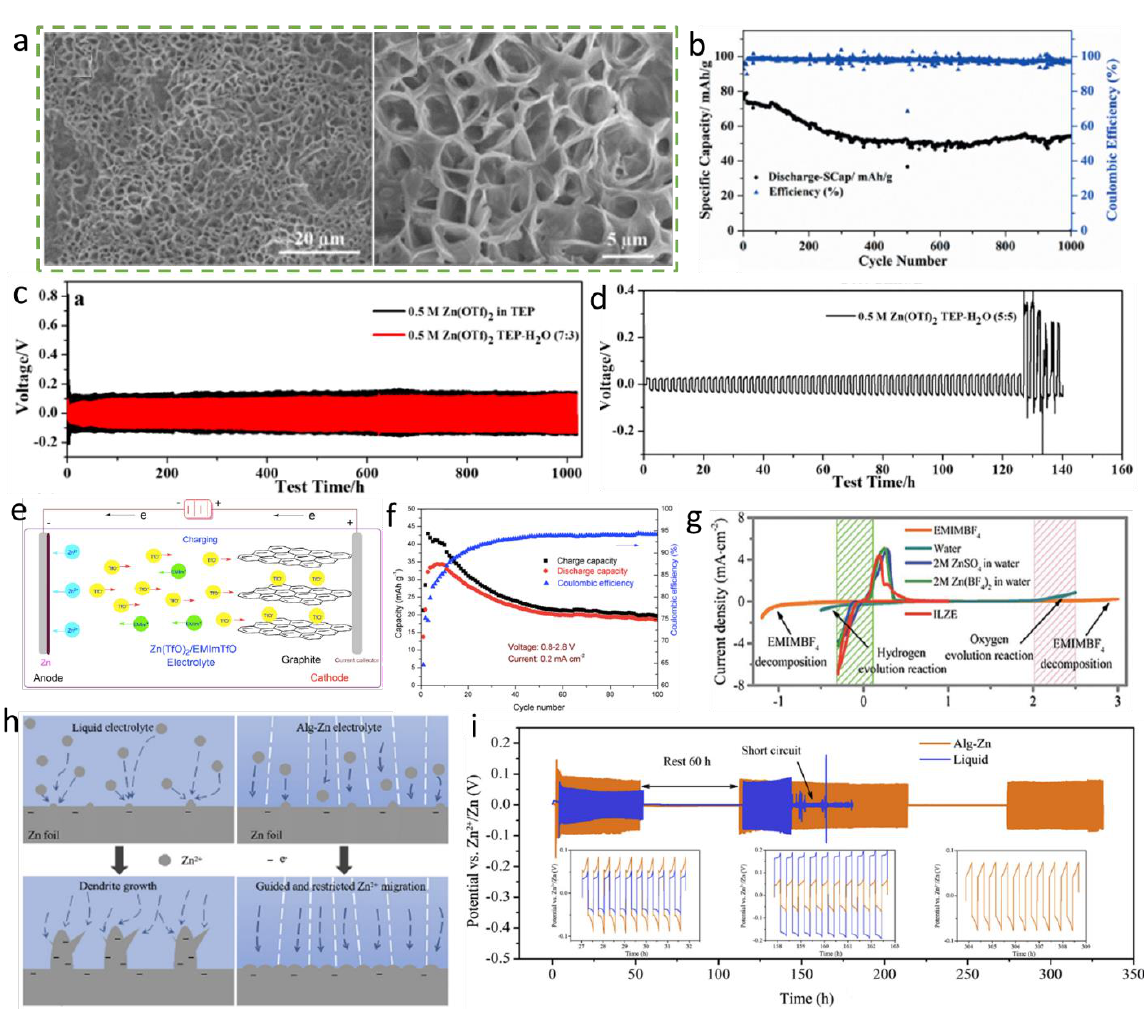
Figure 18. ( a ) SEM images of the morphologies grown at the Zn anode after plating/stripping 1000 times (2000 h) in a 0.5 M Zn(CF 3 SO 3 ) 2 -TEP electrolyte (left) and magnified view (right), ( b ) cycling performance of a Zn ǁ KCuHCf cell at a rate of 1 C in 0.5 M Zn(CF 3 SO 3 ) 2 in a TEP:H 2 O (7:3) electrolyte, ( c , d ) influence of water content on the cycling performance of Zn/Zn symmetrical cells. (Reproduced with permission. [202] Copyright 2019, John Wiley & Son). ( e ) Schematic illustration of the working mechanism of the Zn/graphite DIB and ( f ) Cycling performance of the Zn/graphite DIB. (Repro- duced with permission. [203] Copyright 2019, Springer Nature). ( g ) Electrochemical window of wa- ter and EMIMBF 4 ionic liquid. (Reproduced with permission. [204] Copyright 2020, John Wiley & Son). ( h ) The mechanism for the deposition behaviors of Zn 2+ in ZnSO 4 +MnSO 4 aqueous electrolyte and Alg-Zn electrolyte, and ( i ) Zn plating/stripping performance of the symmetric cell under a cur- rent density of 1.77 mA cm − 2 at room temperature after resting for 60 h. (Reproduced with permis- sion. [207] Copyright, Elsevier).